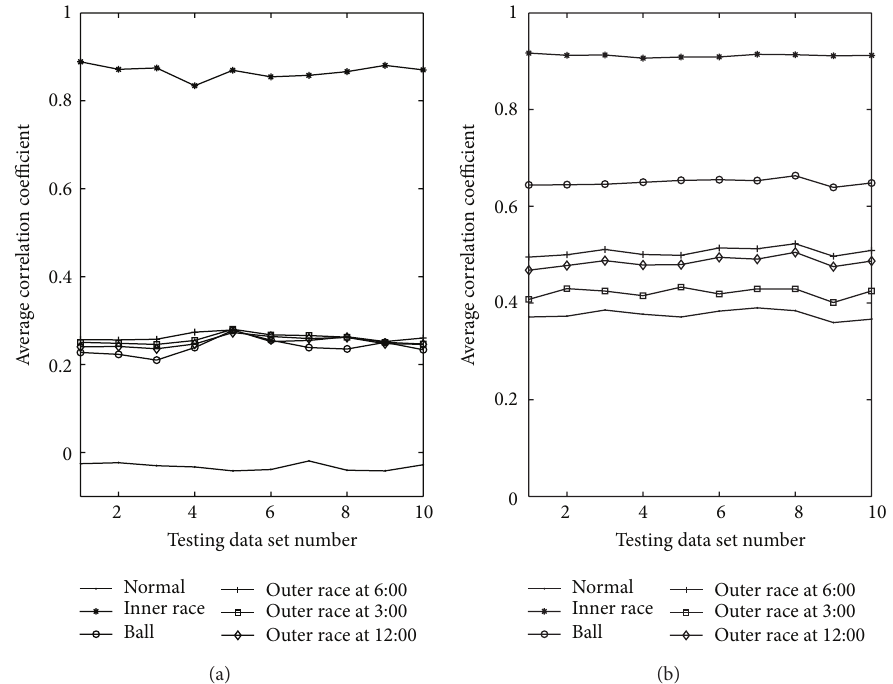
Figure 10: Detection results of data set B with an inner race fault according to morphology spectrum correlation analysis: (a) signal based triangular SE; (b) flat SE.